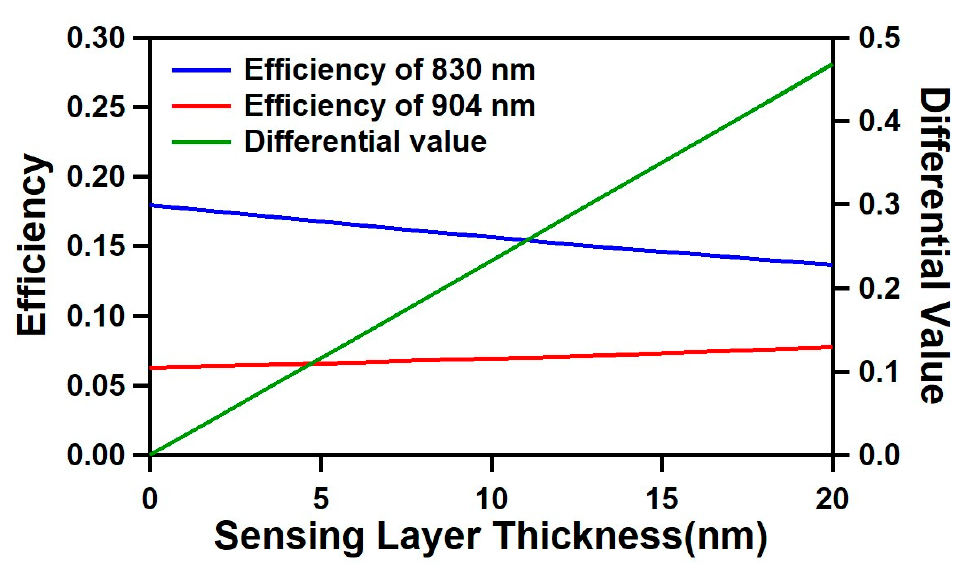
Figure 2. Simulation results showing efficiencies of 830 nm ( blue ) and 904 nm ( red ) wavelengths and differential values ( green ) versus the sensing layer thickness in the range between 0 and 20 nm.